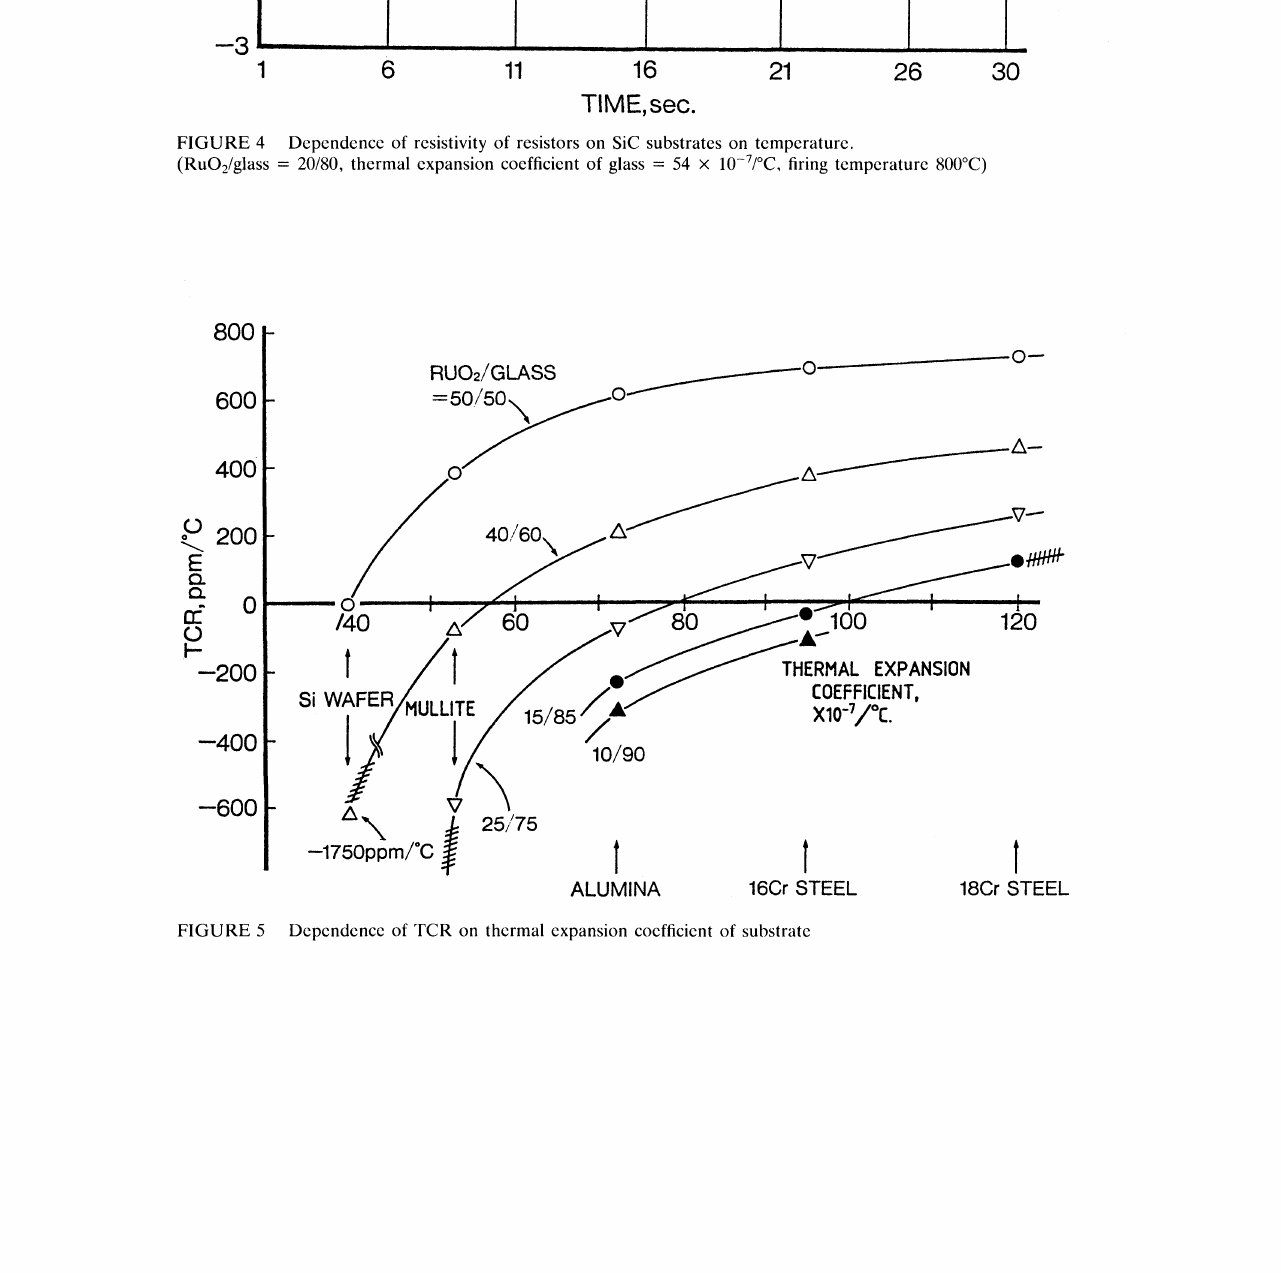
FIGURE 4 Dependence of resistivity of resistors on SiC substrates on temperature. (RuOz/glass